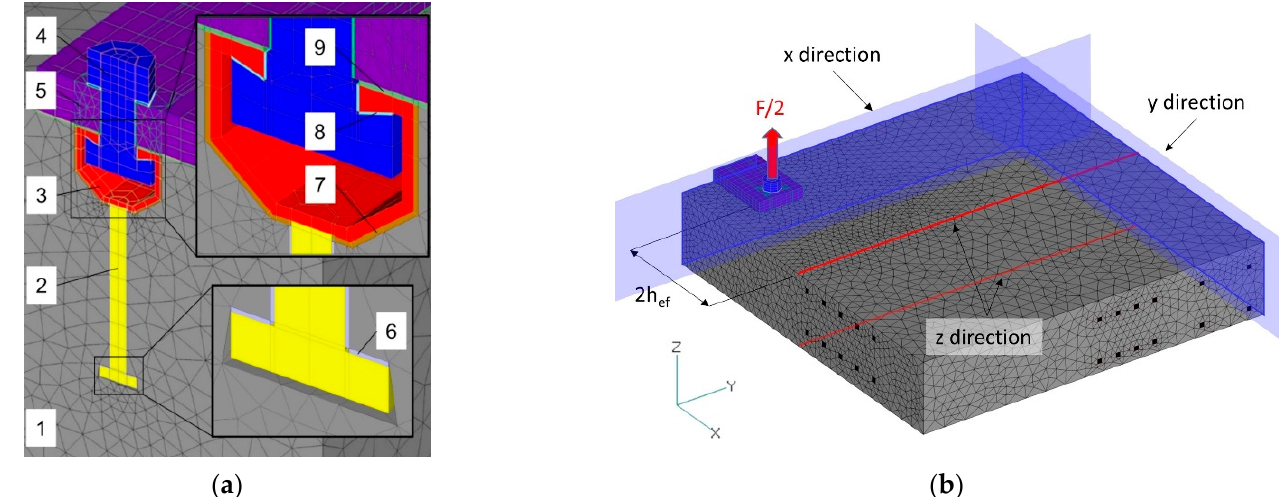
Figure 2. ( a ) FE discretization: 1—concrete slab, 2—anchor, 3—channel, 4—T-bolt with nut, 5—steel plate, 6—anchor interface, 7—channel interface, 8—T-bolt interface, 9—teflon sheet; ( b ) FE model and boundary conditions.